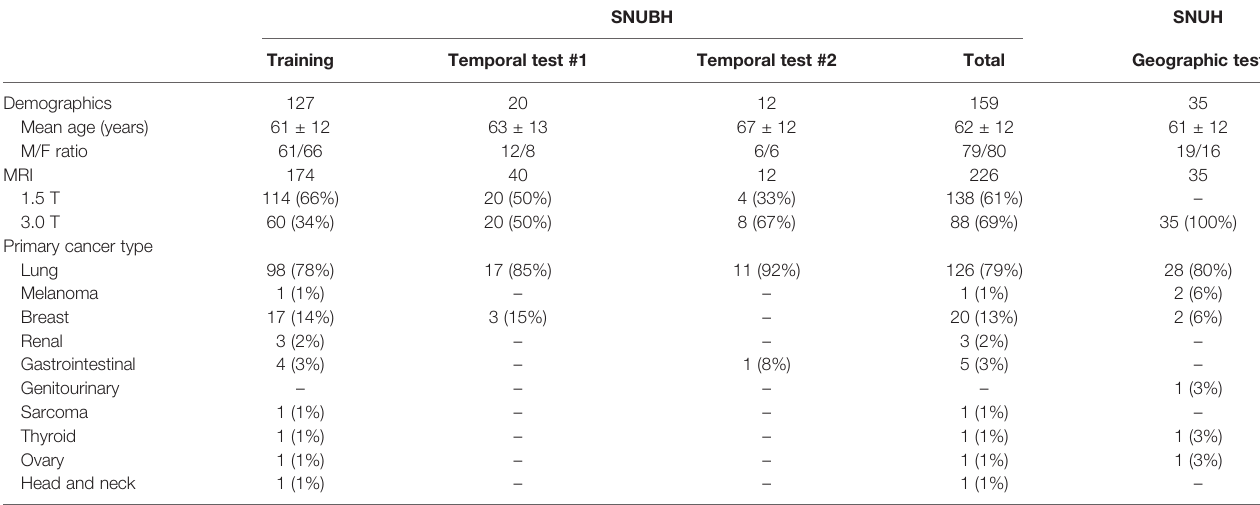
TABLE 1 | Clinicodemographic patient characteristics according to the dataset.